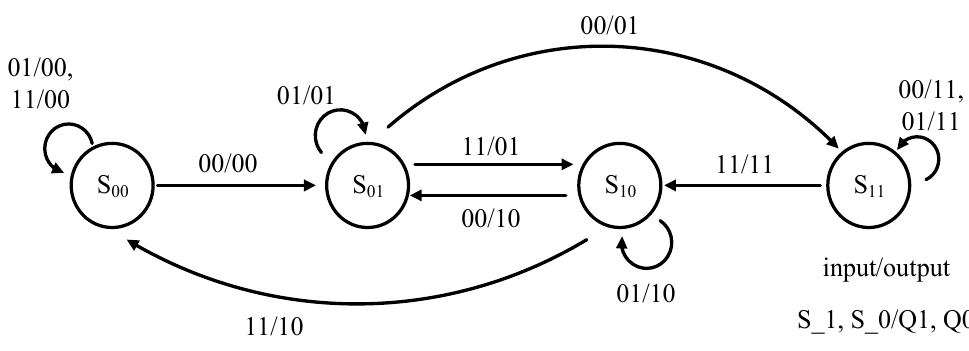
Figure 7. State machine of temperature range auto-selecting circuit.